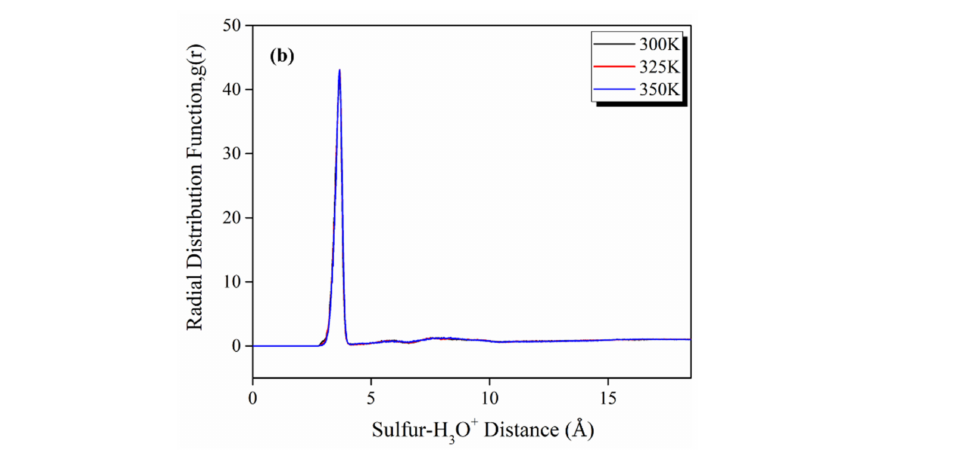
Figure 9. RDFs of ( a ) sulfur–sulfur atom pair and ( b ) sulfur–hydronium ion pair in SPAES-6 polymer at different temperatures.